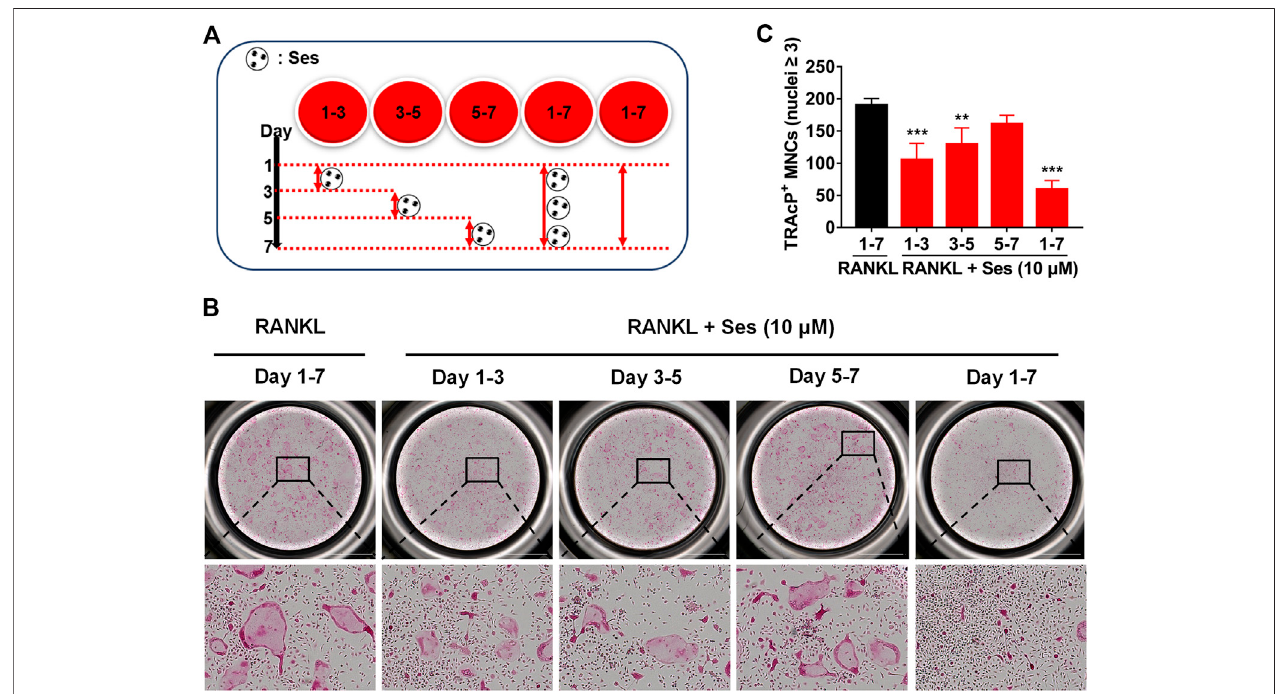
FIGURE 2 | Ses inhibits osteoclast formation induced by RANKL in the early and middle stages. (A) Effect of Ses on osteoclast formation in a time-dependent manner. (B) The representative image ofTRAcP staining showed that Ses (10 μ M) was used to treat BMMs within a speci fi ed period oftimeduring osteoclast formation (scale (cid:1) 2,000 μ M). (C) Quanti fi cationofthenumberofTRAcP-positivemultinucleatedcells(nuclei ≥ 3).Theabovedataareexpressedasthemean ± SD; n (cid:1) 3;** p < 0.01 and *** p < 0.001. BMMs, bone marrow macrophages; Ses, sesamolin; RANKL, receptor activator of nuclear factor- κ B ligand; TRAcP, tartrate-resistant acid